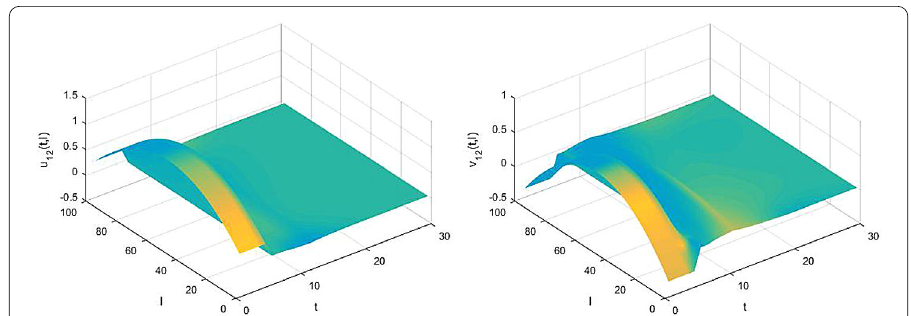
Figure 2 The trajectory of u 12 ( t , l ) and v 12 ( t , l ).